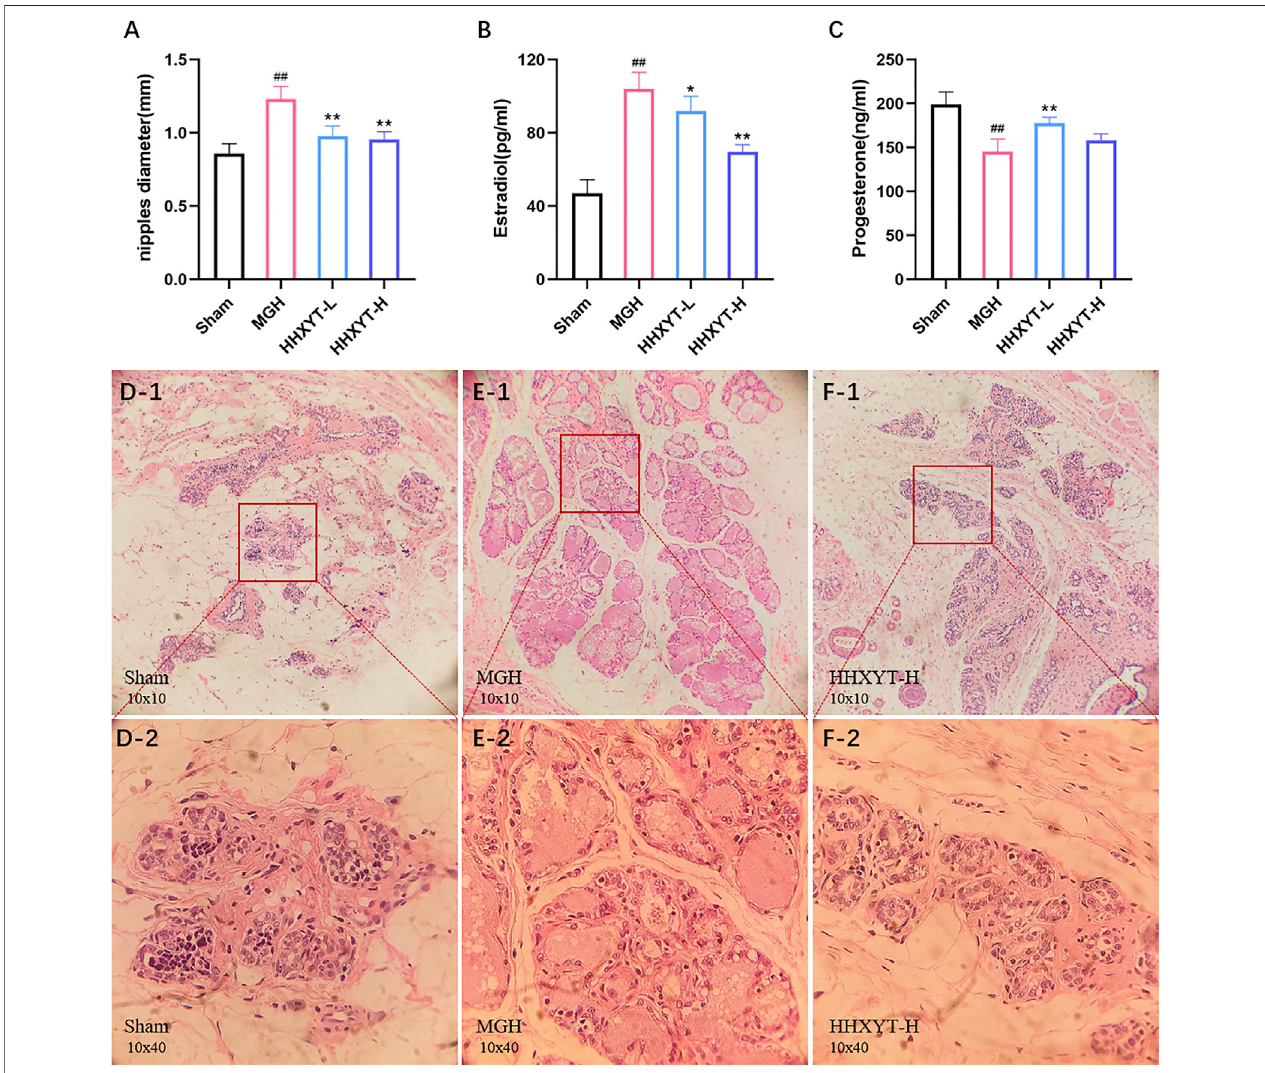
FIGURE 2 | The effect of HHXYT on pharmacodynamic results of the MGH model. (A) The diameter of nipples. The serum levels of sex hormone estradiol (B) and progesterone (C) . n = 6 per group, ## p < 0.01, compared to Sham; * p < 0.05, ** p < 0.01, compared to MGH. HE staining results for mammary gland sections in Sham (D) , MGH (E) , HHXYT-H (F) group (10 × 10: D-1, E-1, and F-1; 10 × 40: D-2, E-2, and